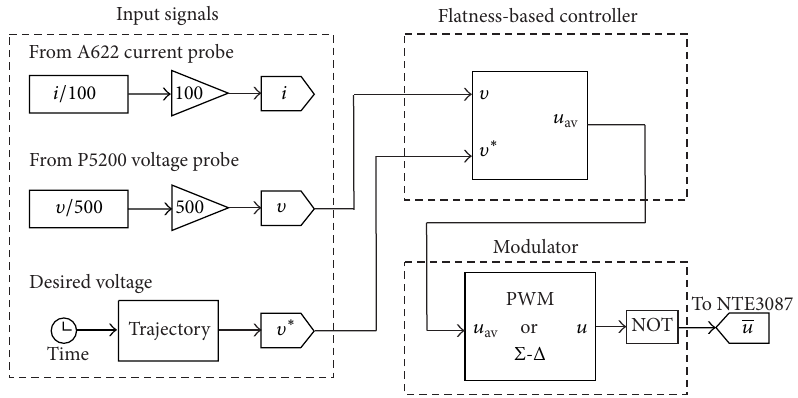
Figure 4: Control block adapted to